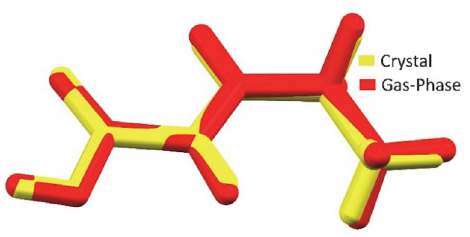
Figure 11: Compound C 5 H 8 O 2 overlap of compound yellow (crystal), red (gas-phase). The anchorage point occurs in the O 2 -C 1 -O 1 -H 1 geometry.